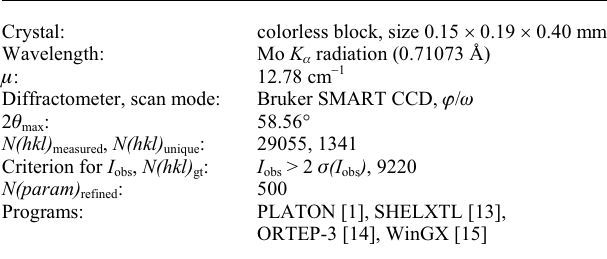
Table 1. Data collection and handling.